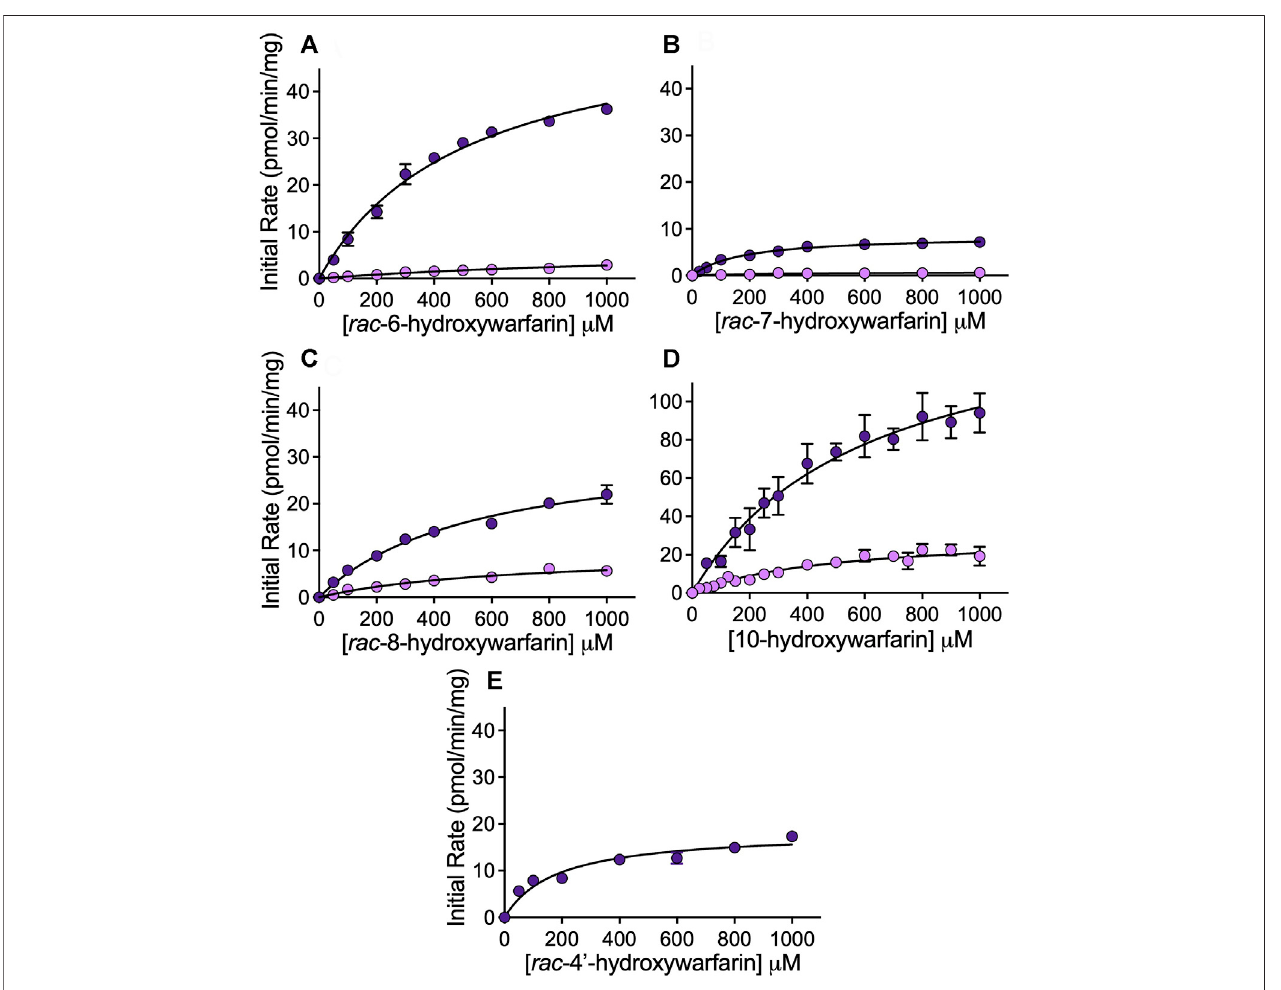
FIGURE 5 | Kinetic pro fi les for reduced metabolites formed from hydroxywarfarin metabolism by human liver cytosol. Steady-state reactions were carried out with 1.0 mg/ml protein human liver cytosol in 50 mM potassium phosphate pH 7.4 with varying concentrations ofsubstrate. Plots of theinitialratesfor alcohol 1 (light purple) andalcohol2(darkpurple)asafunctionofhydroxywarfarinconcentrationwere fi ttoMichaelis-Mentenmechanismsforreductionof (A) rac -6-hydroxywarfarin, (B) rac -7- hydroxywarfarin, (C) rac -8-hydroxywarfarin, (D) 10-hydroxywarfarin isomer mixture (note difference in scaling versus other plots), and (E) rac -4 ′ -hydroxywarfarin. The corresponding Michaelis-Menten parameters for the best fi t curve are reported in Table 2 . Error bars represent standard deviation of at least six replicates.